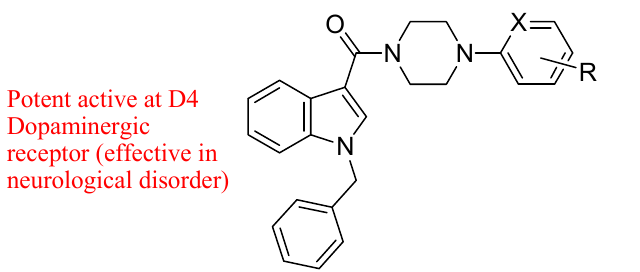
Figure 26. Functionalized 1-benzyl-3-[4-aryl-1-piperazingl]carbonyl- 1H